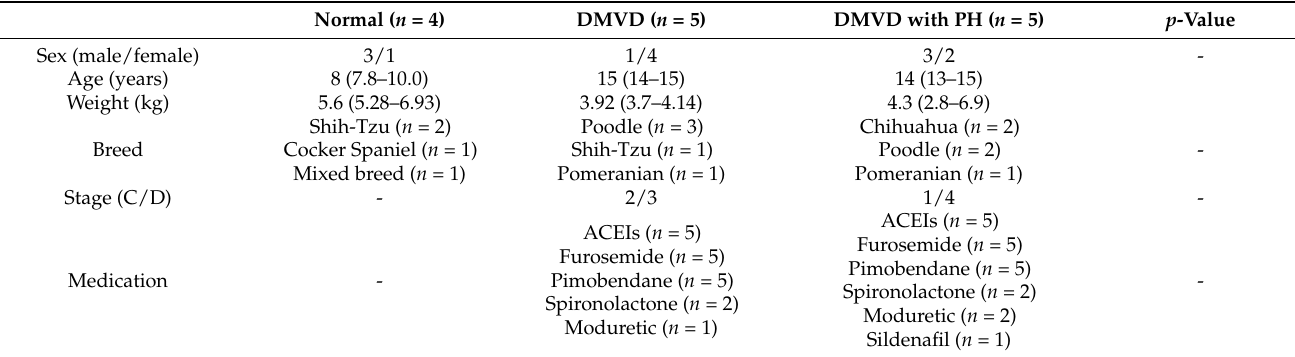
Table 2. Signalment of dogs in the normal, degenerative mitral valve disease (DMVD) and degenera- tive mitral valve disease with pulmonary hypertension (DMVD with PH)